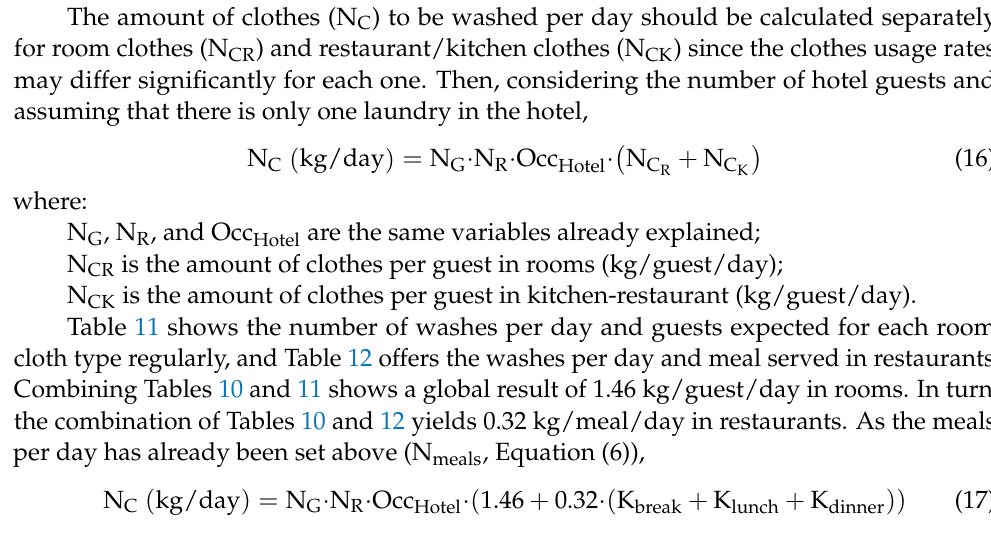
Table 11. Average washes per guest and day for each cloth in